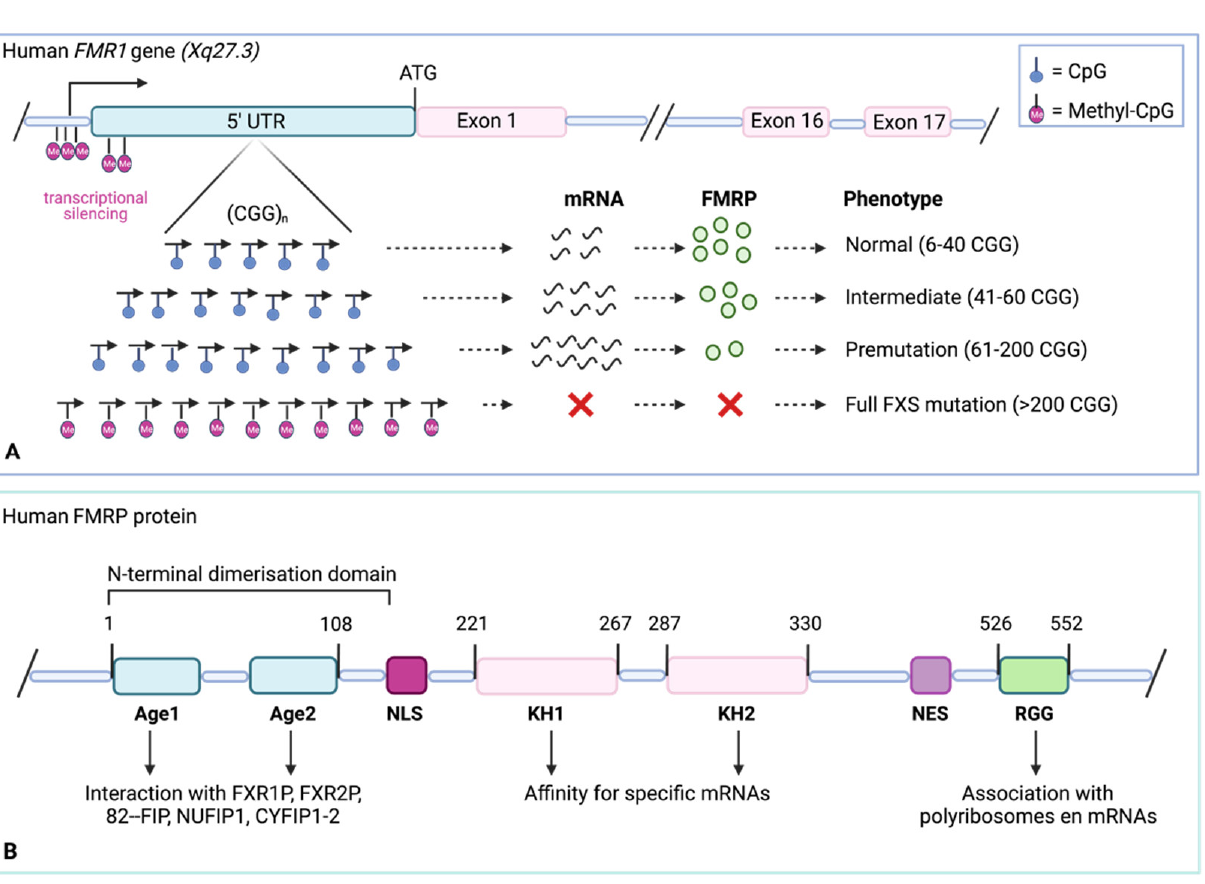
Figure 1. FMR1 gene structure and FMRP protein domains. ( A ) The human FMR1 gene located on chromosome Xq27.3. FMR1 is defined by seventeen exons with different methylation states of CpG islet located in the 5′UTR, resulting in distinct Fragile X-related phenotypes. The 5′UTR is the common site of an expansion mutation in the FXS. ( B ) Human FMRP contains several conserved protein domains such as K homology domains (KH1, and 2 together with an RGG box which enable mRNA binding capacity. The Agenet (Age) domains act on histones and trimethylated lysine residues and facilitate FMRP protein–protein interactions.